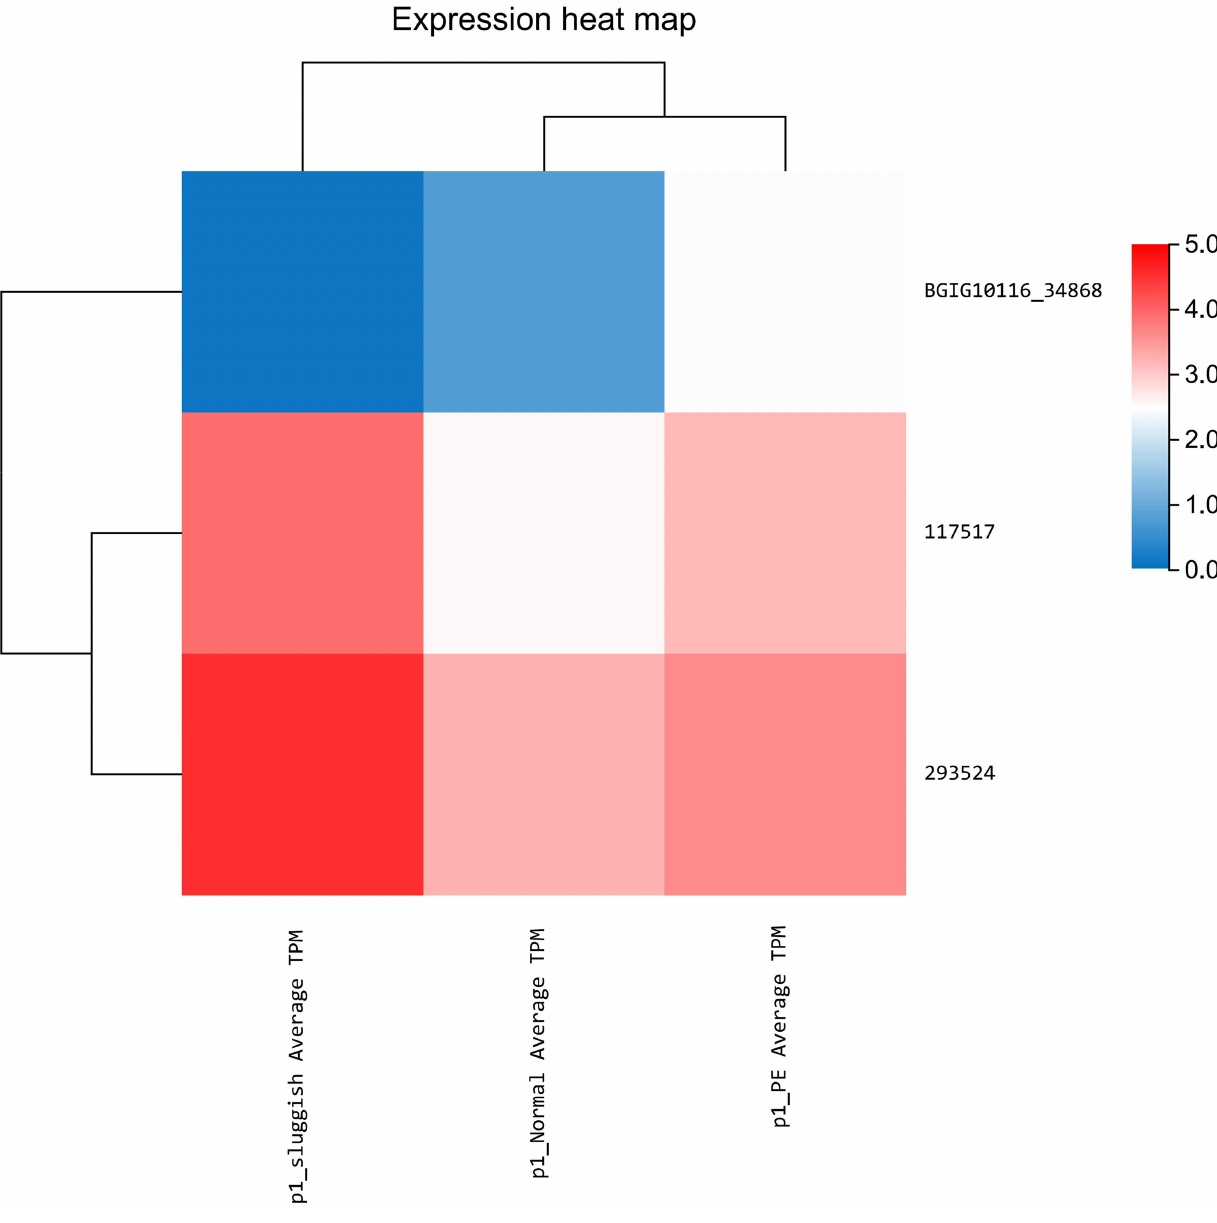
FIGURE 3 | Expression of three key genes in premature ejaculation